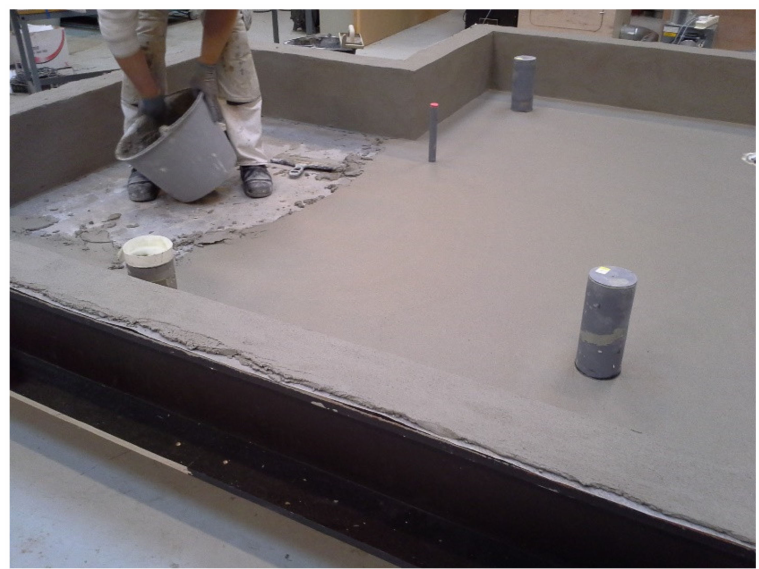
Figure 7. Mounting the test material inside the mock-up for System E, which is a two-component fixed mortar paste combined with edge reinforcements, epoxy and elastic pipe